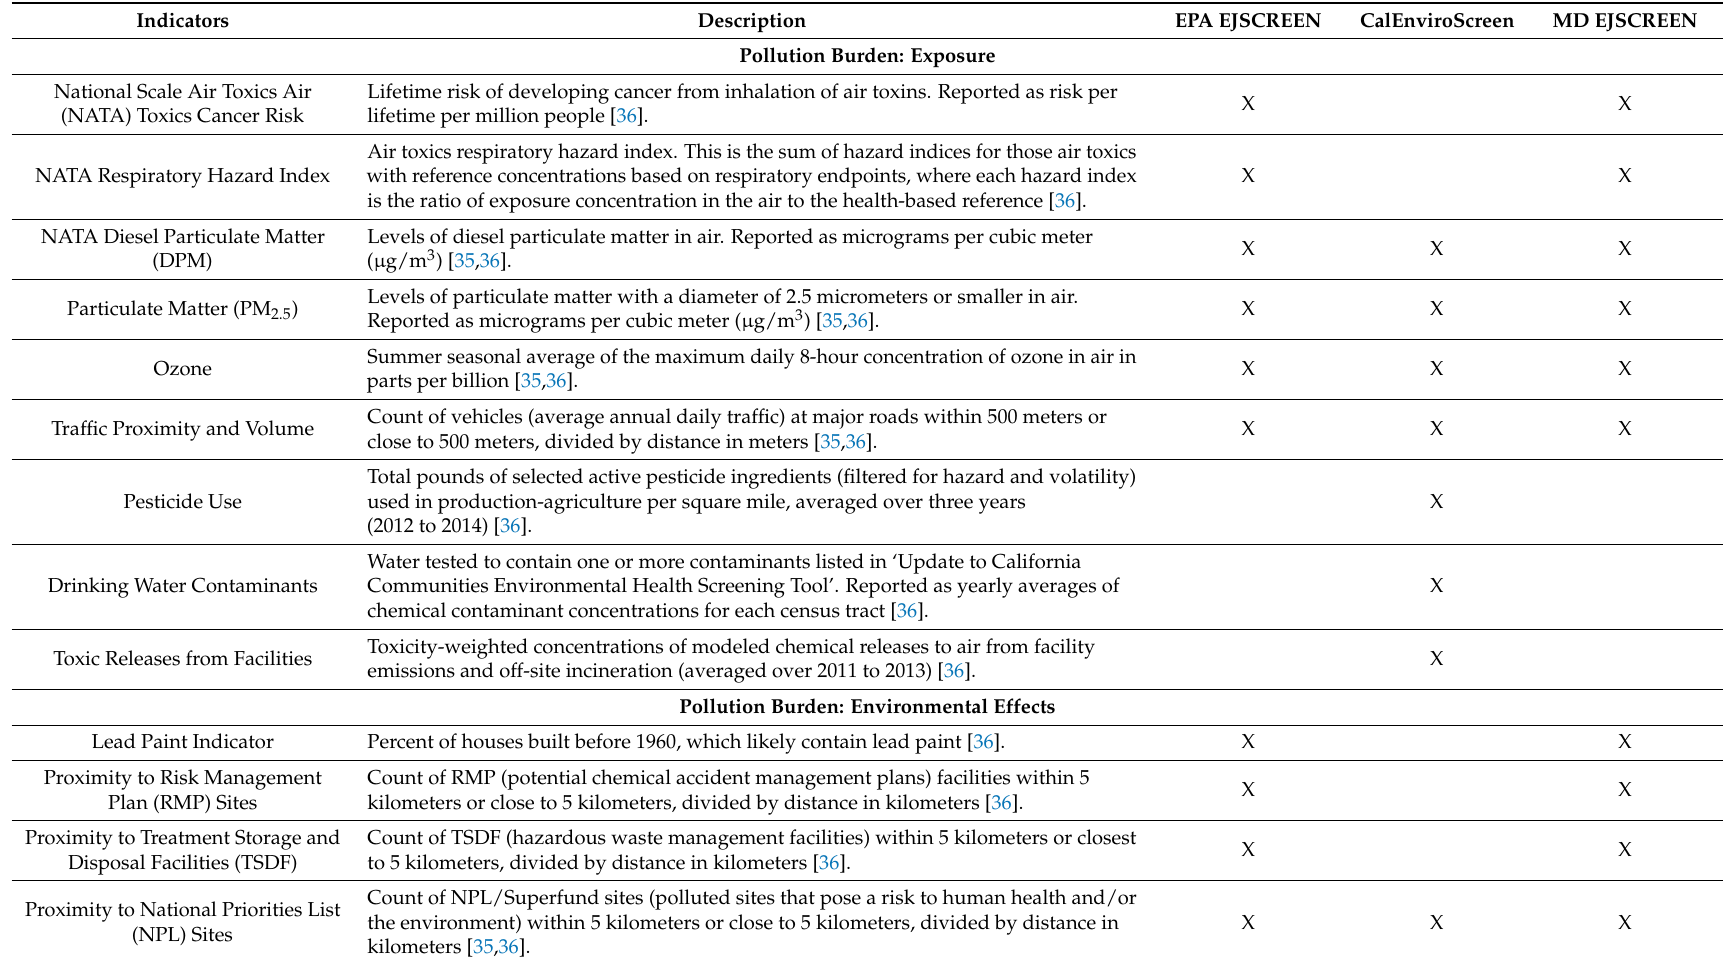
Table 1. Comparison of EJ (Environmental Justice) screening tool